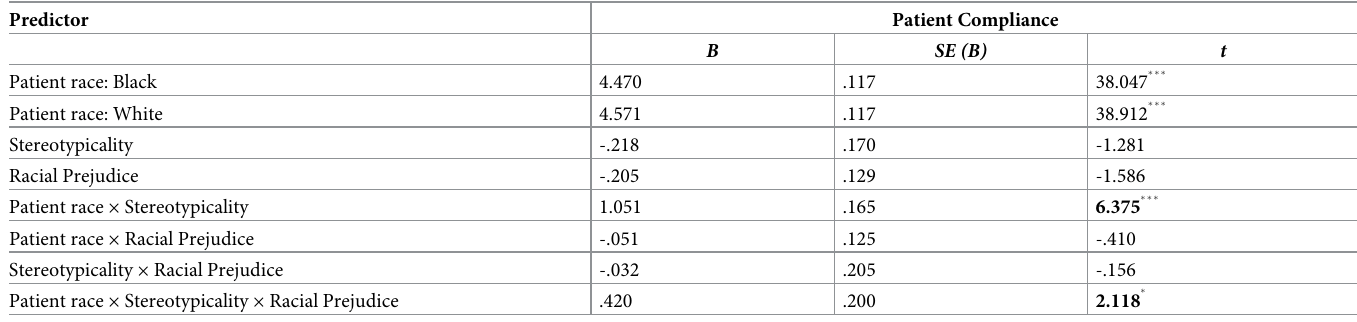
Table 2. Summary of multilevel analysis for variables predicting the perceived patient